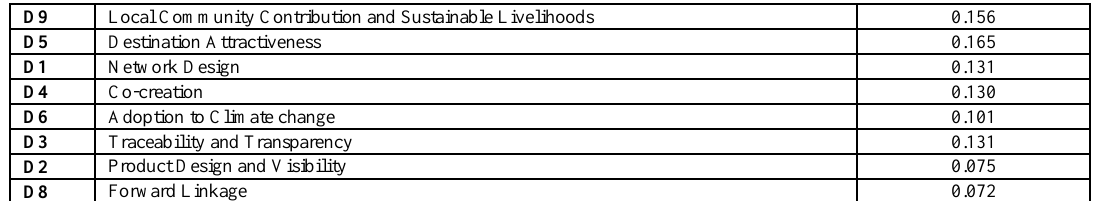
Table 3. Priorities for